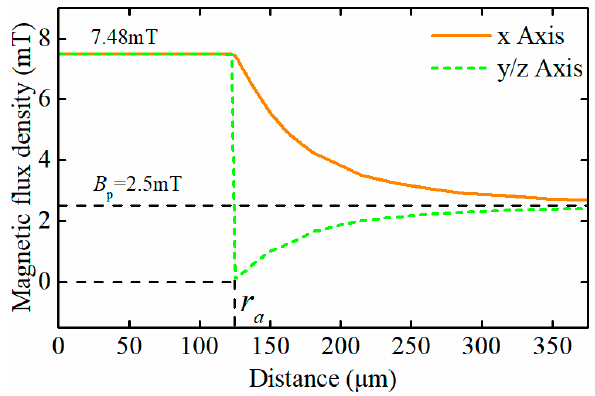
Figure 4. Magnetic flux density along the x , y and z axis.